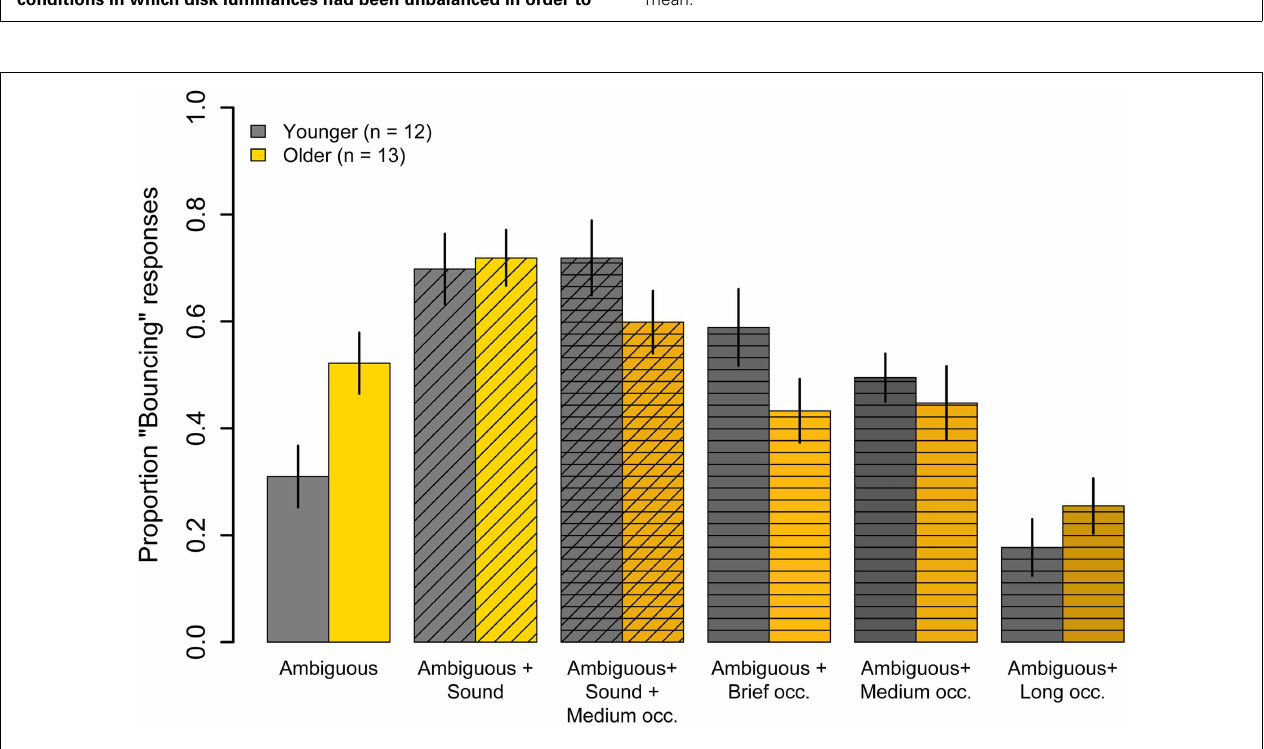
maximize “Streaming” and “Bouncing” judgments . Data are for 12 younger and 13 older subjects. Error bars are ± 1 standard error of the mean.